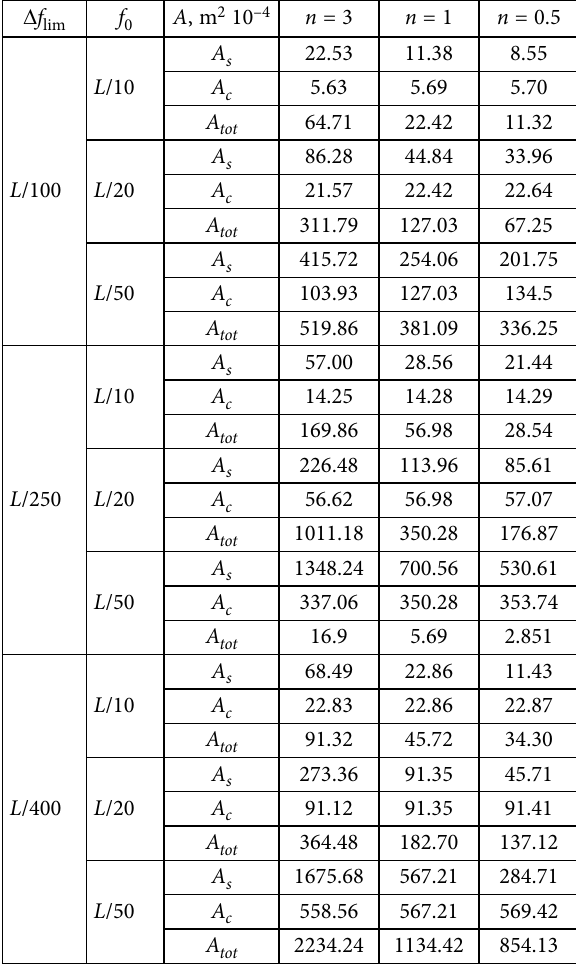
Figure 1. Relative difference in mass at span lenght L = 50 m and L = 25 m